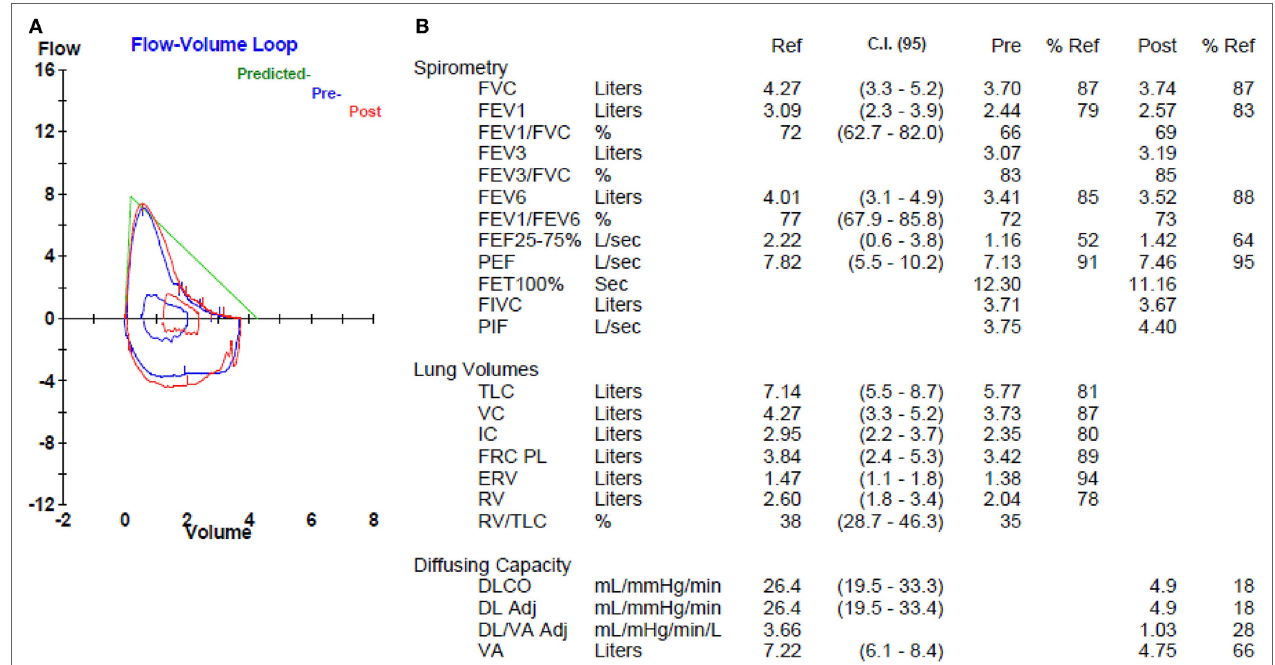
FigURe 2 | Pulmonary function testing in a patient with combined pulmonary fibrosis and emphysema. Flow volume loop (A) shows mild obstructive morphology, but normal spirometry (B) . Lung volumes (B) are normal. Diffusion capacity (B) is markedly